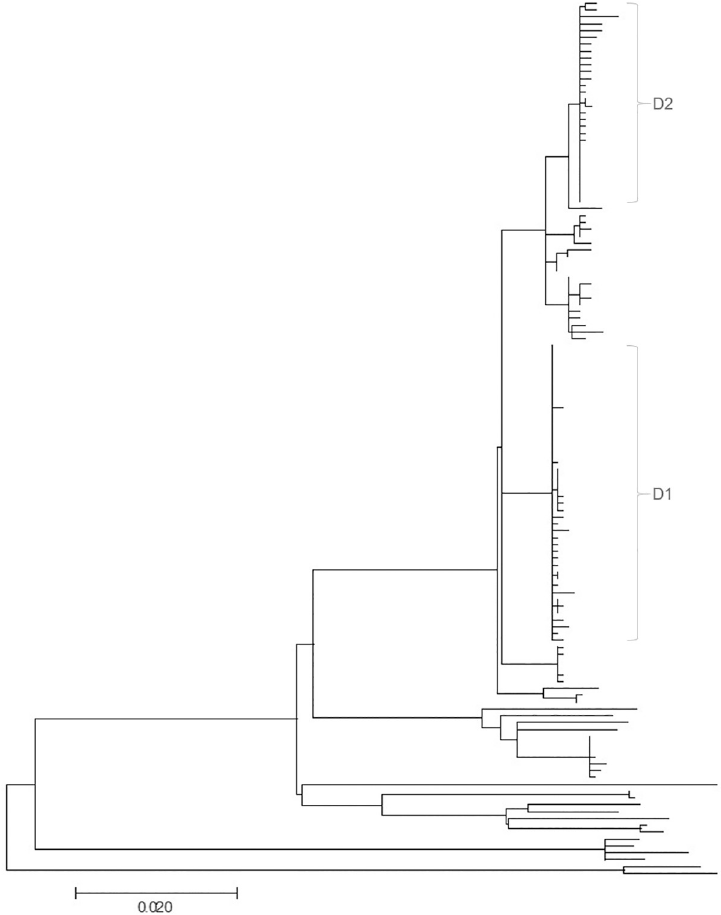
Fig 4. Maximum likelihood phylogeny of sequenced MAP isolates. Phylogenetic tree based on SNP data from 128 sequenced MAP isolates with 1472 nucleotide positions, using the Tamura-Nei model. A total of 94 different genotypes were recovered. The tree with the highest log likelihood (7449.75) is shown. Branch lengths is measured in the number of substitutions per site. D1 and D2 indicate isolates belonging to the two dominant strains.